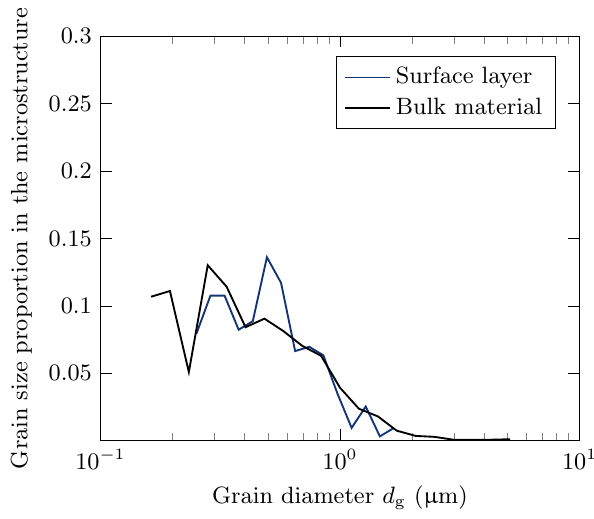
Figure 16. Grain diameter distribution in the bulk material and the surface layer for a 5 ◦ rake angle γ (cid:48) o of the minor cutting edge ( v c = 250m/min, f z = 0.015mm, a p = 0.25mm, a e = 0.5mm, α (cid:48) o = 2 ◦ ).